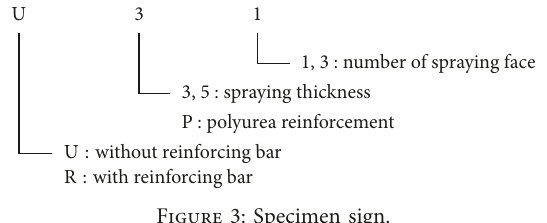
Figure 3: Specimen sign.